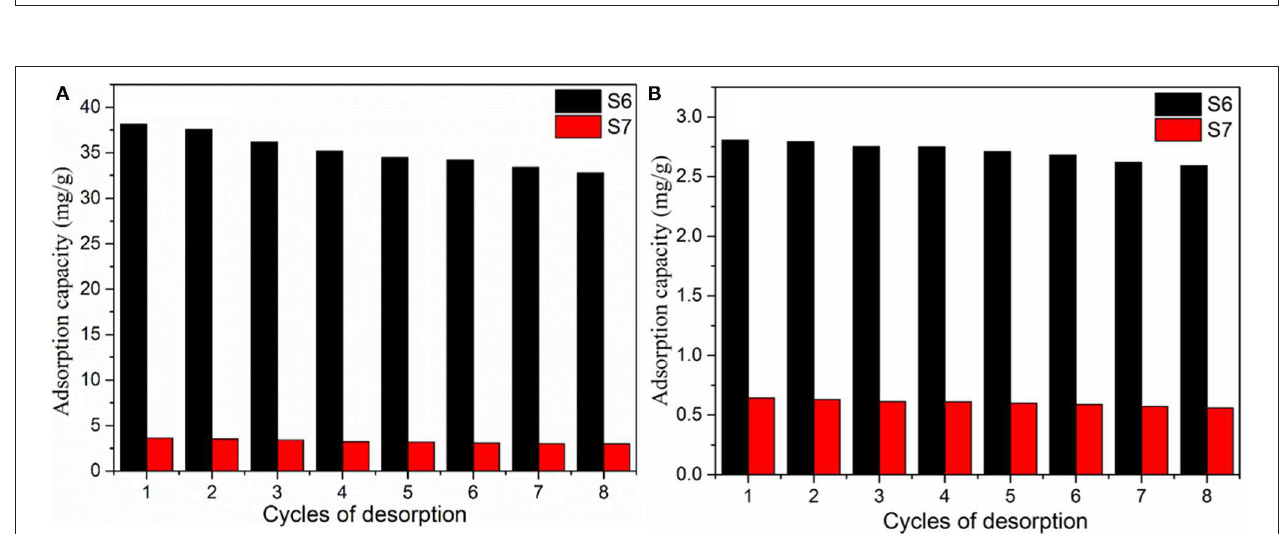
FIGURE 6 | The reusability of samples S6 (Mg2 + ) and S7 (TMCS) for different adsorbate (A) Methylene blue, (B) Rhodamine B.